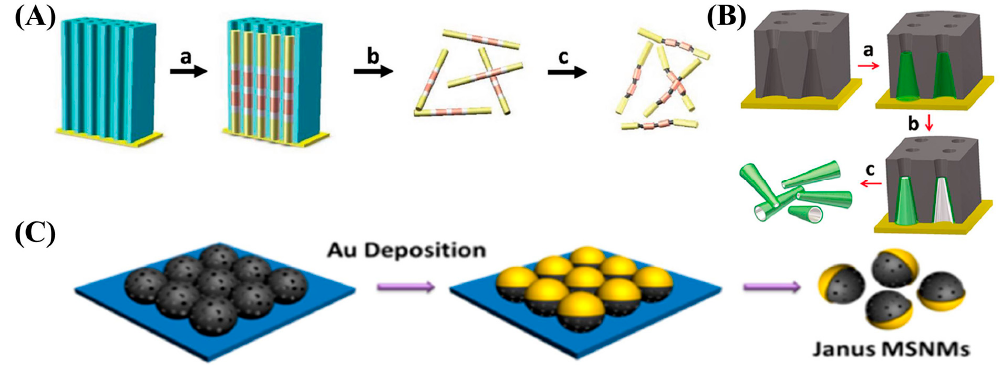
Figure 5. Fabrication schemes of template-assisted MNMs. ( A ) Schematic illustration of AAO template-assisted fabrication of the metal nanowires. Reproduced with permission [88]. Copyright 2011, American Chemical Society; ( B ) The fabrication process of PC template-assisted electrodeposition of micro/nanorockets. Reproduced with permission [58]. Copyright 2016, WILEY-VCH; ( C ) Fabrication scheme of spherical Janus MNMs. Reproduced with permission [81]. Copyright 2016, American Chemical Society.